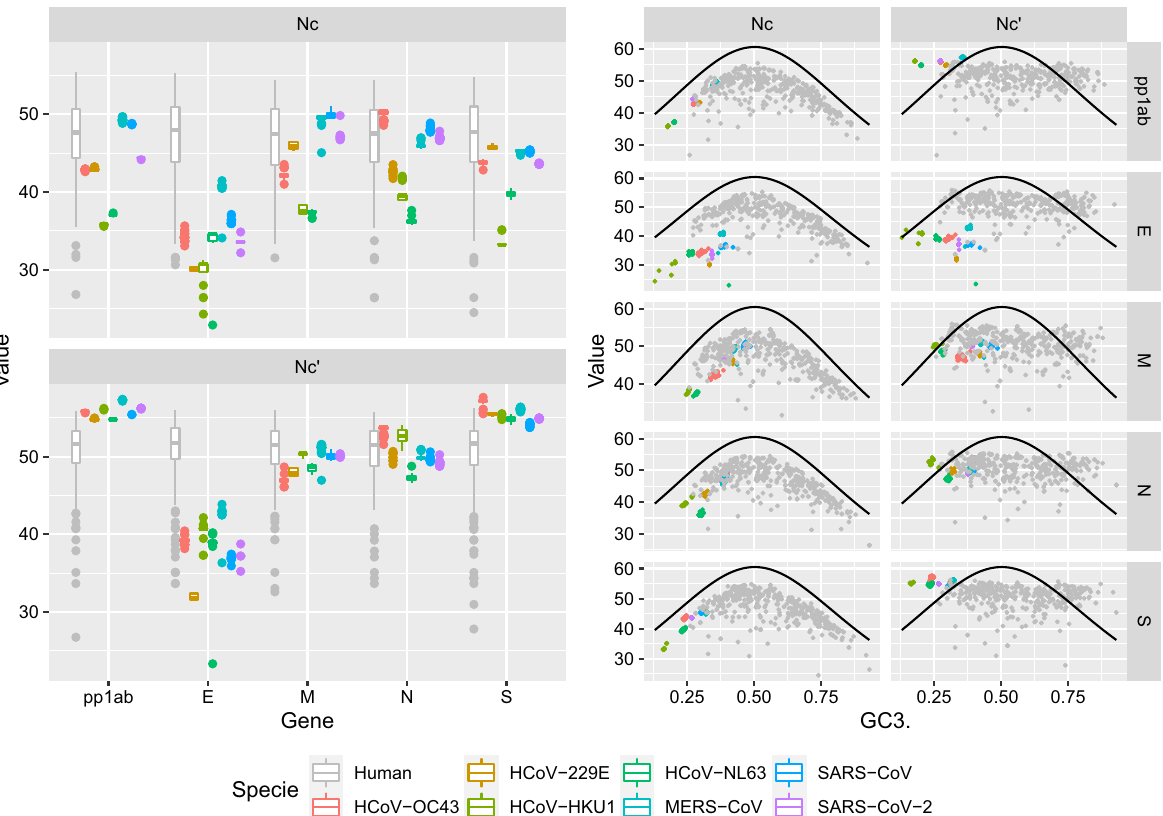
Figure 4. Left figure: Boxplot reporting the Nc and Nc ′ values of HCoV species (color-coded). For comparison, the host value distribution (in grey) is reported nearby each gene. Right figure: Scatterplot reporting the relationship between Nc and Nc ′ and GC3 content of HCoVs coding sequences. HCoVs proteins have been color-coded while the host lung genes have been reported in grey. The line representing the expected Nc values, which would result from GC3 composition being the only factor influencing the codon usage bias, has been